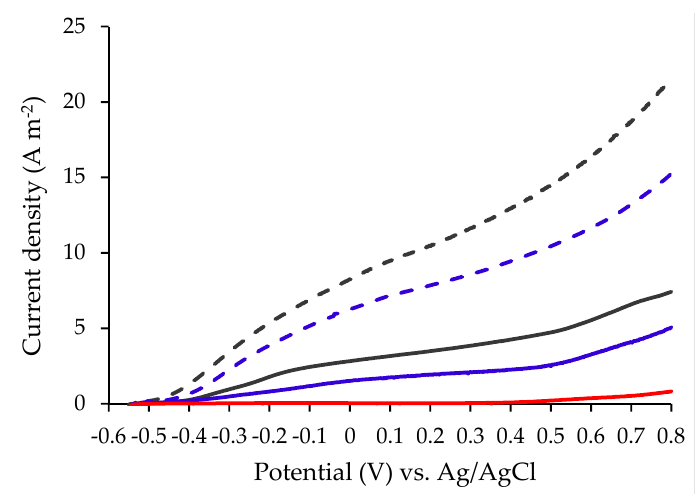
Figure 1. Linear Sweep Voltammetry ( LSV) polarization curves for a bacterial anode made of CC ( ), COMB ( ), SS ( ); CCP ( ) and COMBP ( ) in a single-cell microbial electrolysis cell (MEC) containing Geobacter medium and 0.1 M PB, pH7. Scan rate was 5 mV s − 1 versus Ag/AgCl.